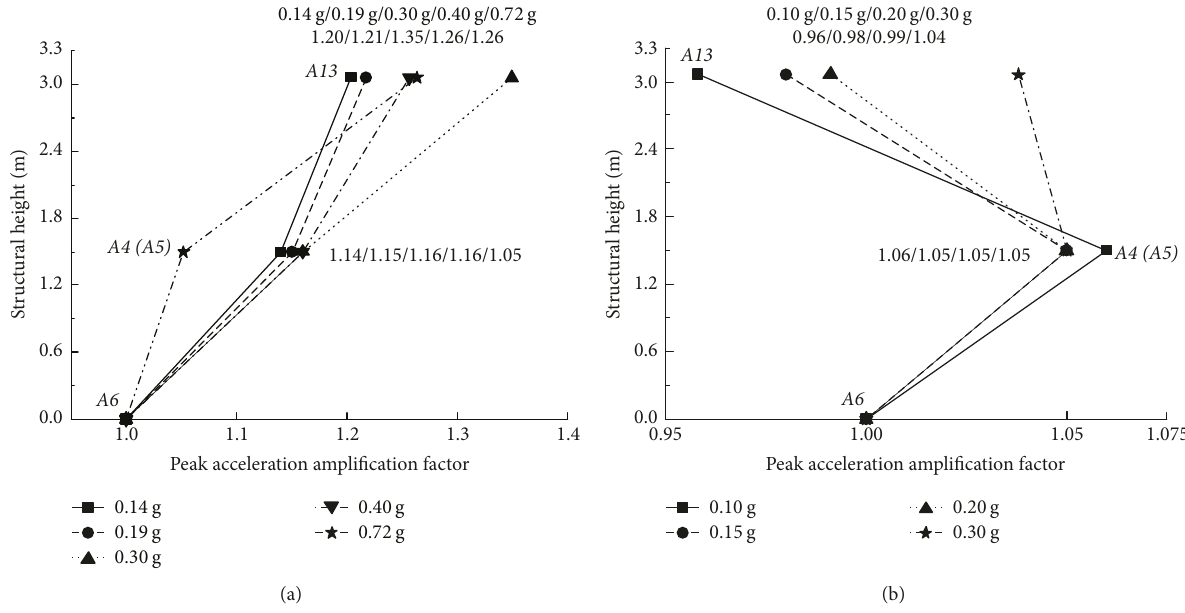
Figure 12: Peak acceleration amplification factors of the model structure: (a) under Wolong record input and (b) under El Centro record input.